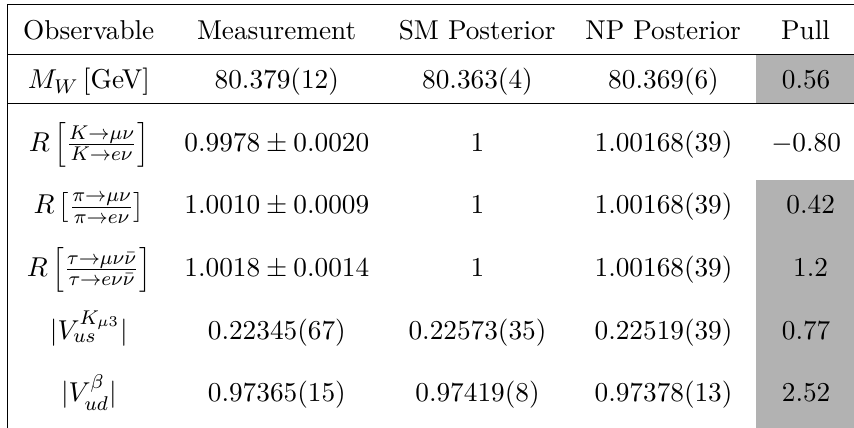
Table 5 . Posteriors for the observables with the largest pulls with respect to the SM in our model in which N mixes with electrons and Σ 1 with muons. Note that | V K µ 3 us | and | V β Lagrangian parameters but the predictions for this CKM elements as extracted from data assuming the